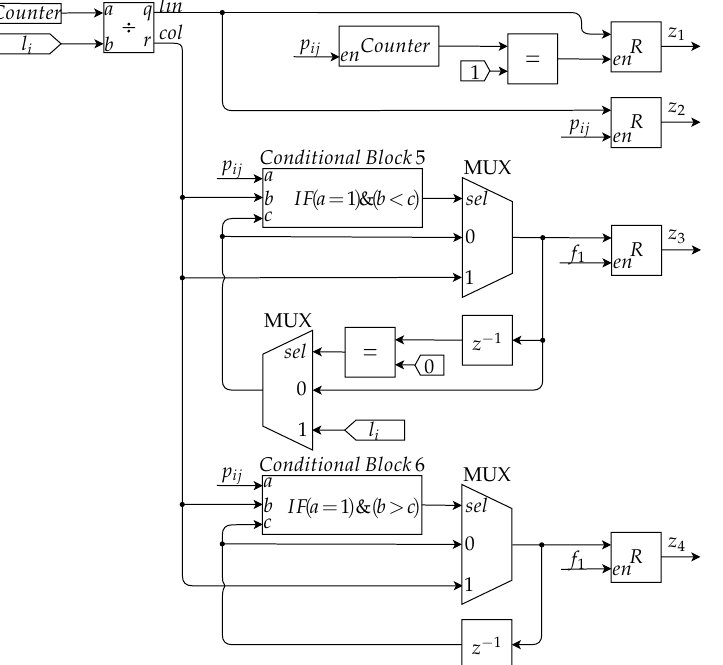
Figure 14. Architecture of the Diameter Calculation Submodule responsible for calculating the extremity